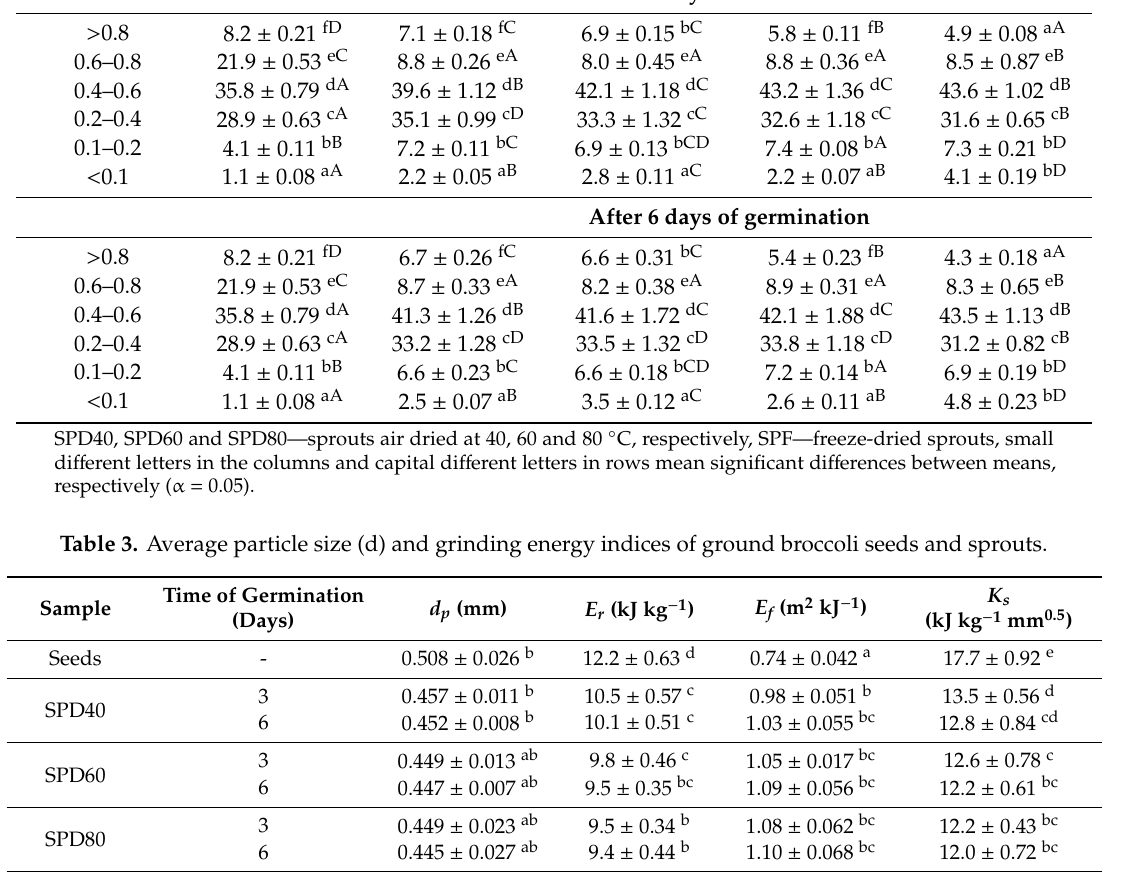
Table 2. Particle size distribution (%) of ground broccoli seeds and sprouts. Range of Class,